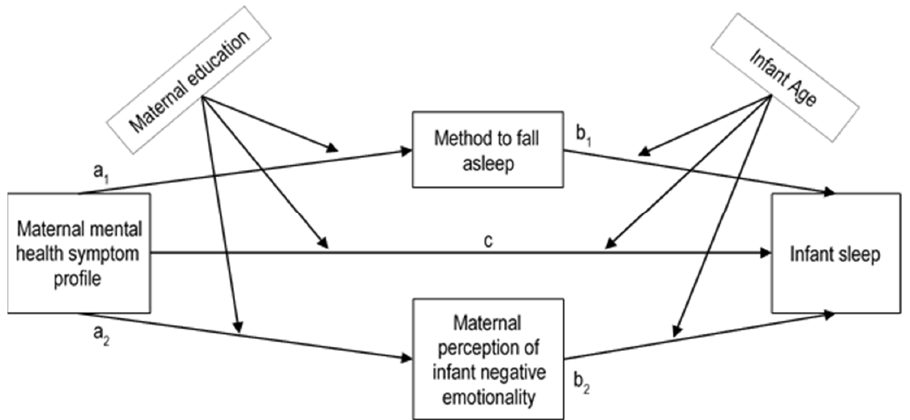
Figure 1. Tested pathways playing a role in the association between a maternal mental health symp ‐ tom profile and an infant sleep outcome. The coefficients a 1 and a 2 are the coefficients of the two linear relationships between each mediator and the independent variable, while the coefficients b 1 , b 2 and c are the coefficients of the linear relationship between the dependent variable, the mediators and the independent